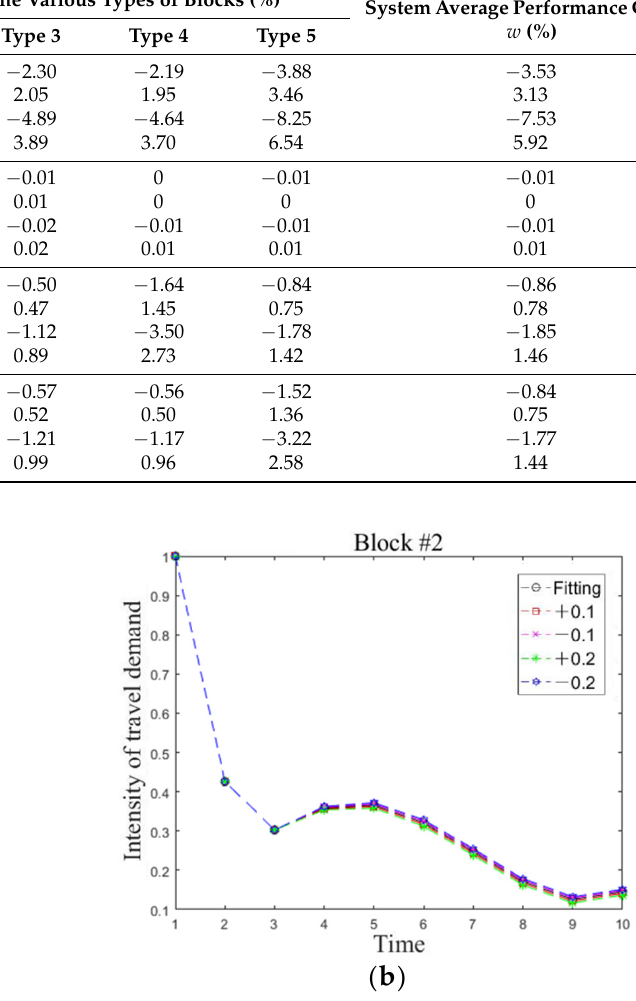
Table 4. Sensitivity analysis table.